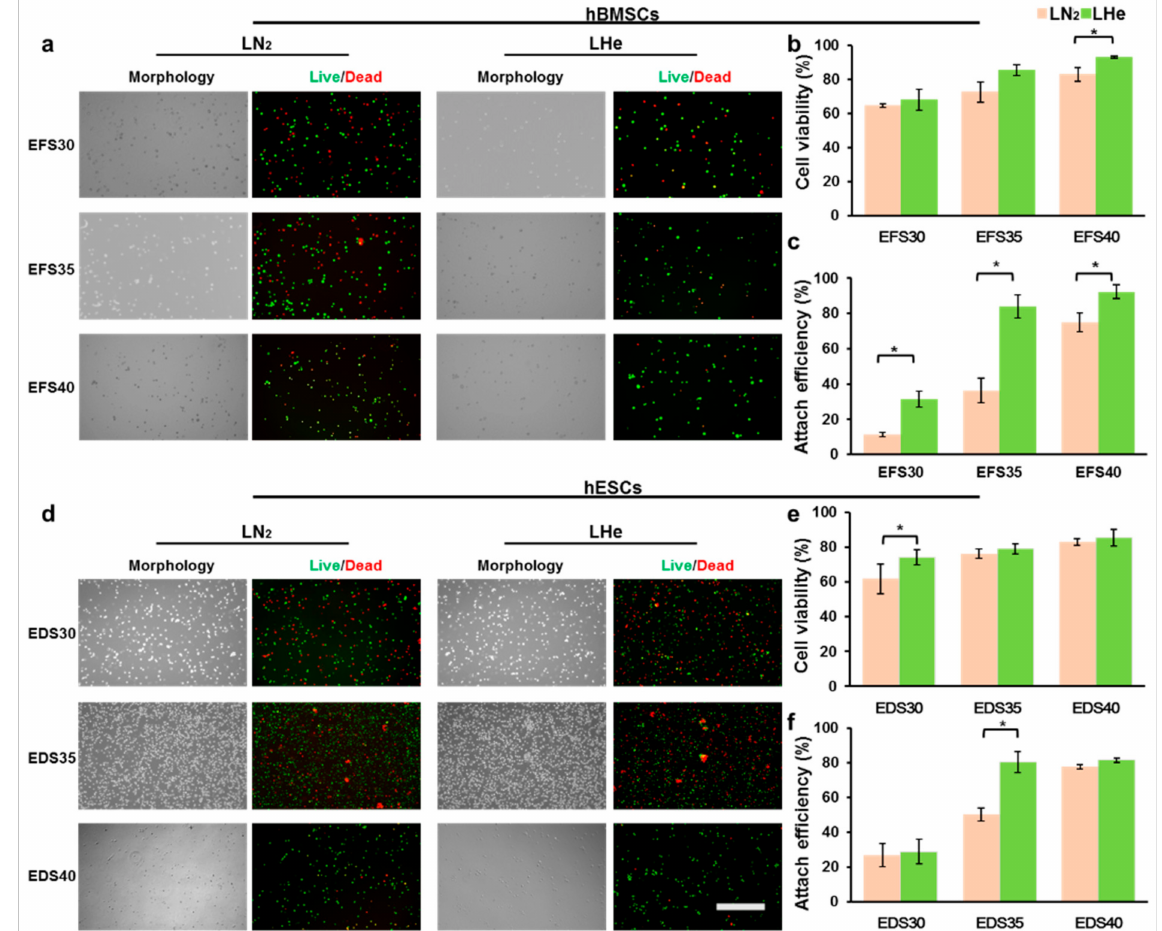
Figure 3. Survival rates of hBMSCs and hESCs after vitrification in LN 2 and LHe with different concentrations of CPAs. ( a ) Morphology and fluorescence micrographs of live (green) and dead (red) hBMSCs after vitrification in EFS30, EFS35, and EFS40. ( b ) Immediate quantitative cell viability of hBMSCs after vitrification. ( c ) Attach efficiency of hBMSCs after vitrification. ( d ) Morphology and fluorescence micrographs of live (green) and dead (red) hESCs after vitrification in EDS30, EDS35, and EDS40. ( e ) Immediate quantitative cell viability of hESCs after vitrification. ( f ) Attach efficiency of hESCs after vitrification. Scale bar: 200 µ m. *: p <